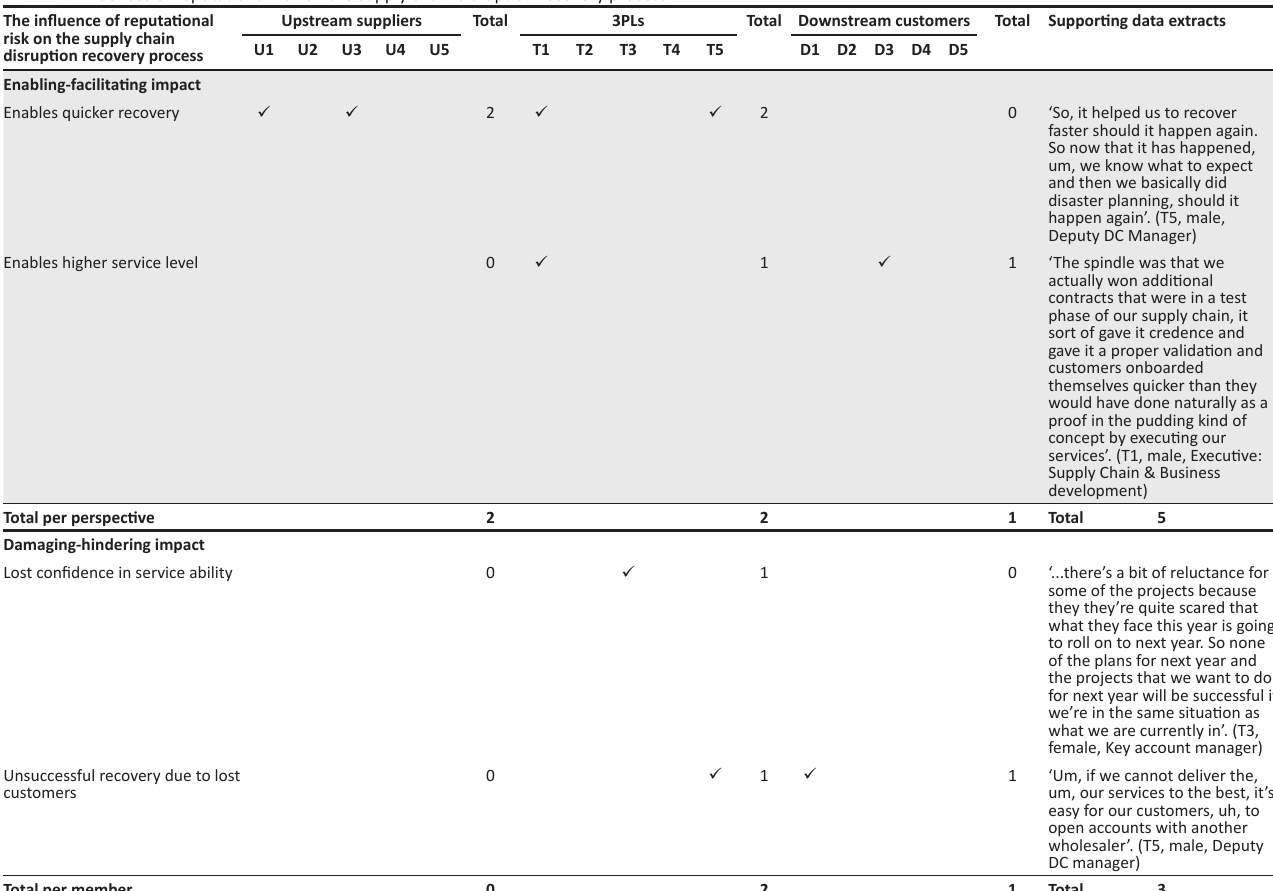
TABLE 4: Influences of reputational risk on the supply chain disruption recovery process. The influence of reputational risk on the supply chain disruption recovery